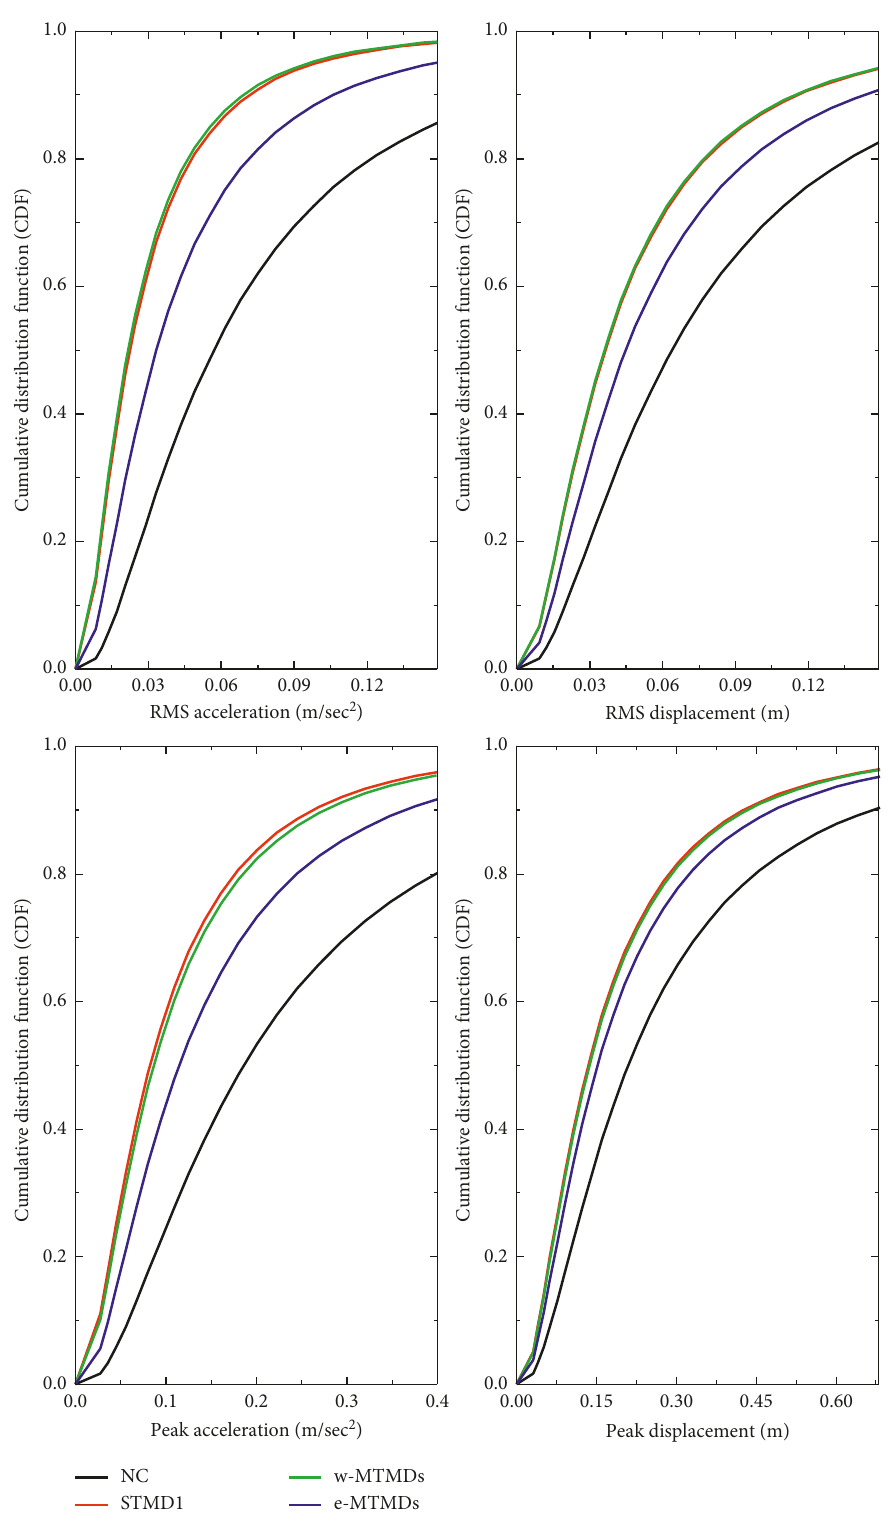
Figure 2: The CDF of responses for the NC, STMD1, w-MTMDs, and e-MTMDs subjected to wind